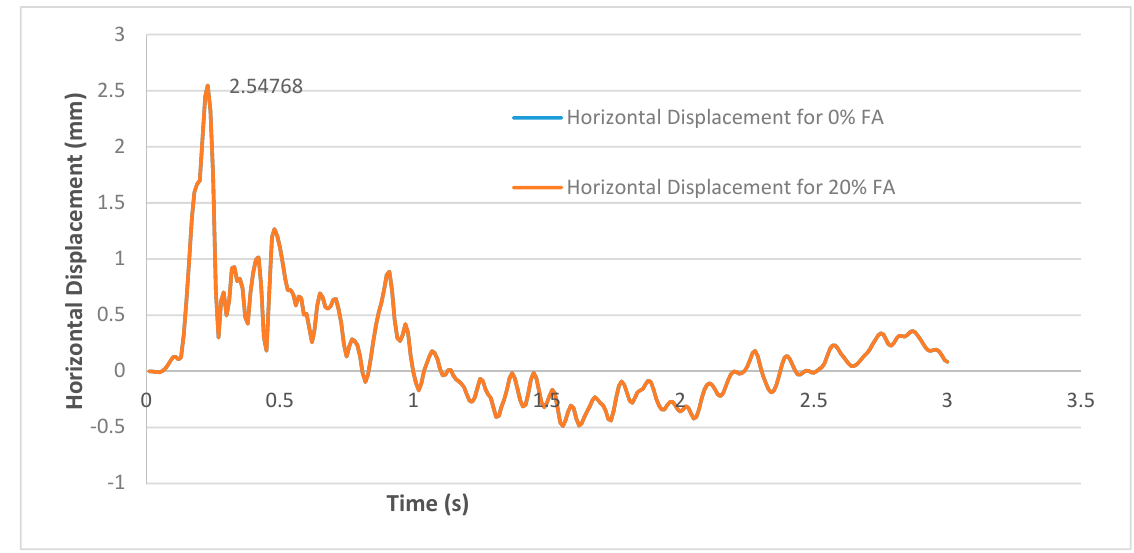
Figure 29. Comparison of time-history curves for horizontal displacement of the pipe crown with the inclusion of 20% and 0% FA due to the Friuli earthquake.